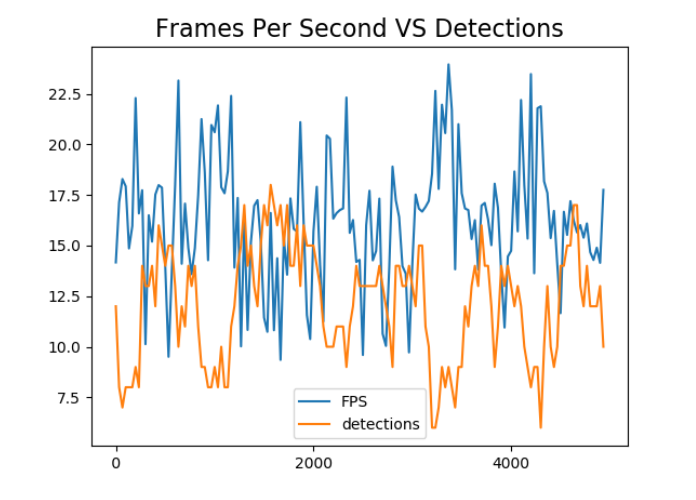
Figure 10. Evolution of the number of frame per seconds processed (FPS) by sensor (blue) and the number of detected objects (red) over time. It can be seen that the FPS are higher when the number of detection is lower. The drop in FPS is mainly due to the SORT algorithm as there are more objects to be tracked, a task not taking advantage of the CUDA cores available on the Jetson TX2.